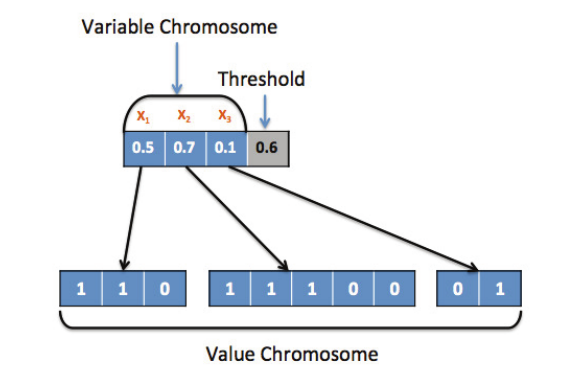
Fig. 6. Combination variable-value for an